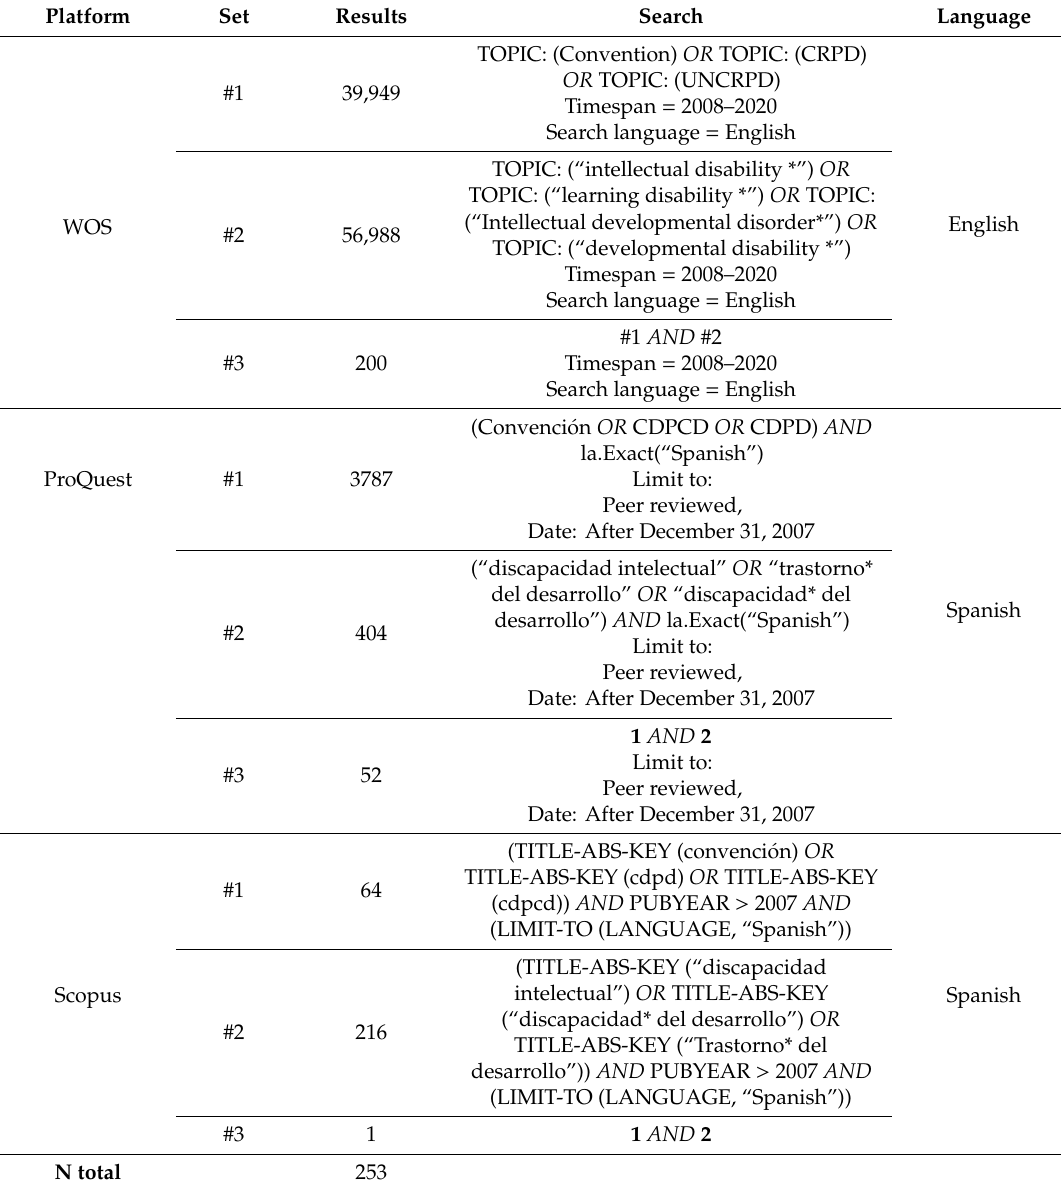
Table 2. Search procedures for English and Spanish